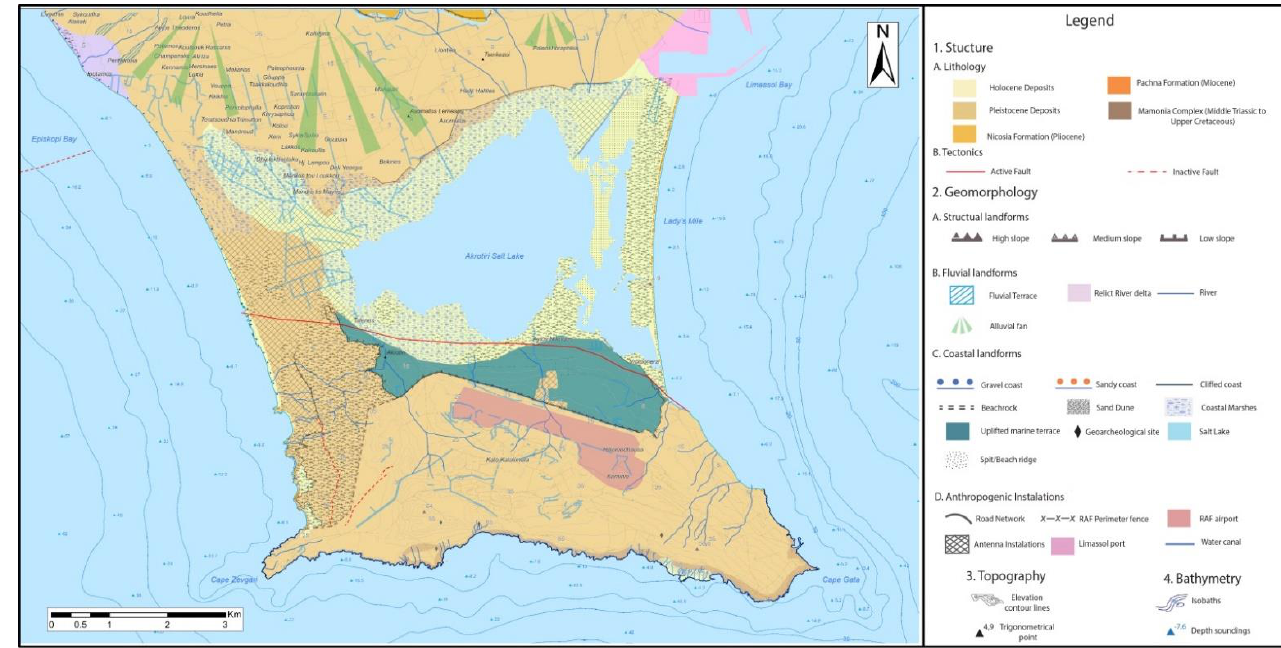
Figure 2. Geomorphological map of the Akrotiri Peninsula [34].